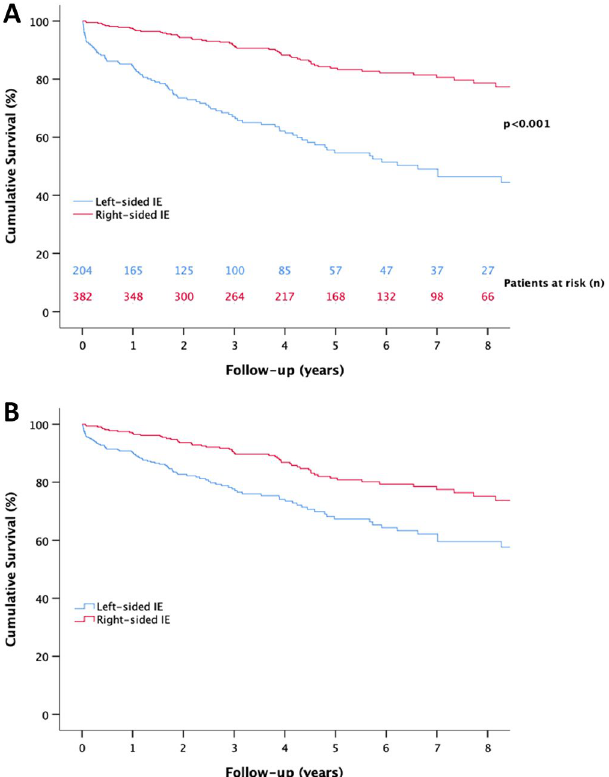
Figure 3. (a) Kaplan Meier estimate of long-term survival , (b) Cox-regression adjusted long-term survival. (a) Survival in people with IDU, for left-sided and right-sided IE. IE infective endocarditis. Kaplan–Meier curves are shown. ( b) Survival in people with IDU, for left-sided and right-sided IE when adjusted for covariates. IE infective endocarditis. Cox-regression plot curves are shown